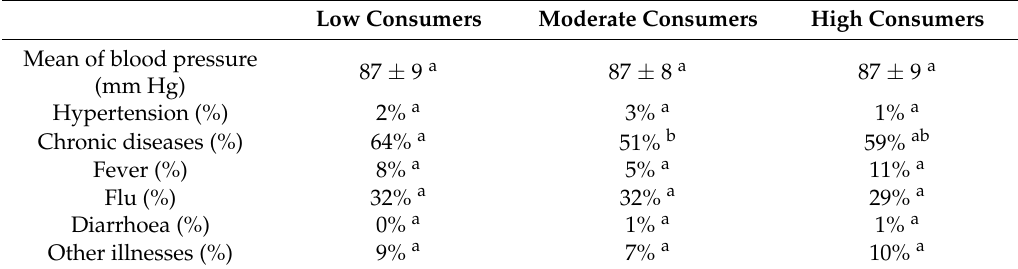
Table 3. Indicators of disease for the three cocoa consumption groups. Values are expressed as mean ± SDM or proportions in each subgroup ( N = 87–92). Different letters mean statistical